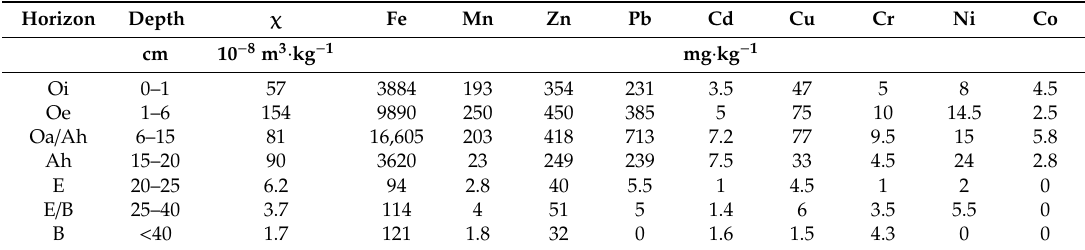
Figure 5. Particles with the composition of iron oxides (light colors of the particles in the photo), darker gray particles are aluminosilicates observed in soil samples. Table 3. Total content of analyzed PTEs (mg·kg − 1 ) in soil horizons.